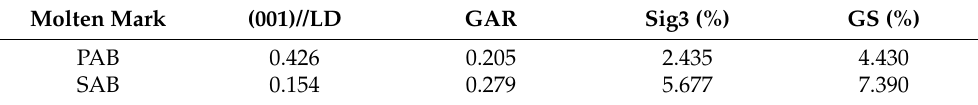
Table 1. Average values of the four discriminant factors. Molten Mark (001)//LD GAR Sig3 (%) GS (%) PAB 0.426 0.205 SAB